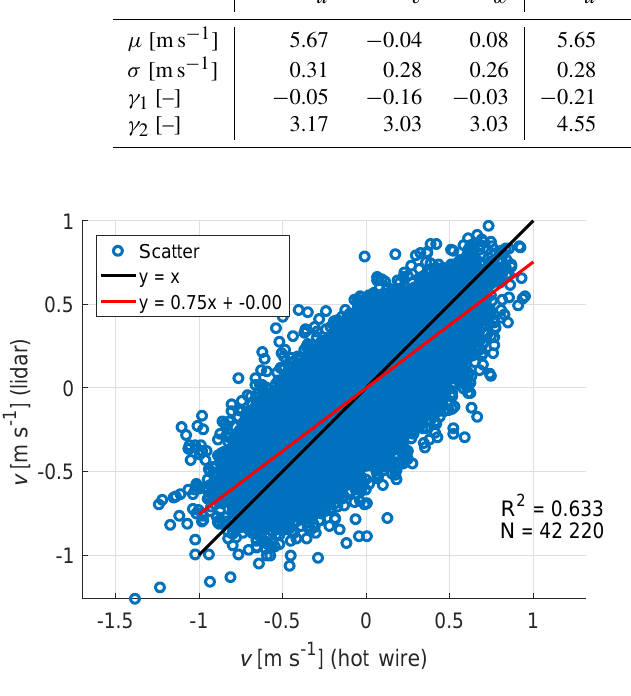
Figure 13. Correlation of the 390Hz v component.